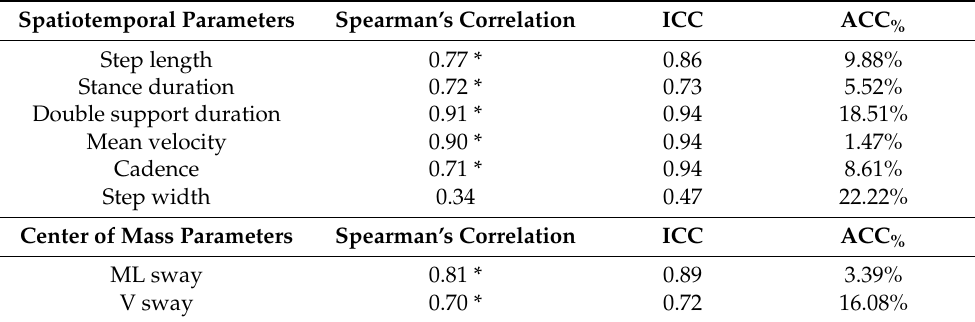
Table 3. Correlation between spatiotemporal and COM parameters between 3D-GA and RGB-D systems: results for Spearman’s correlation coefficient, intra-class correlation (ICC) and